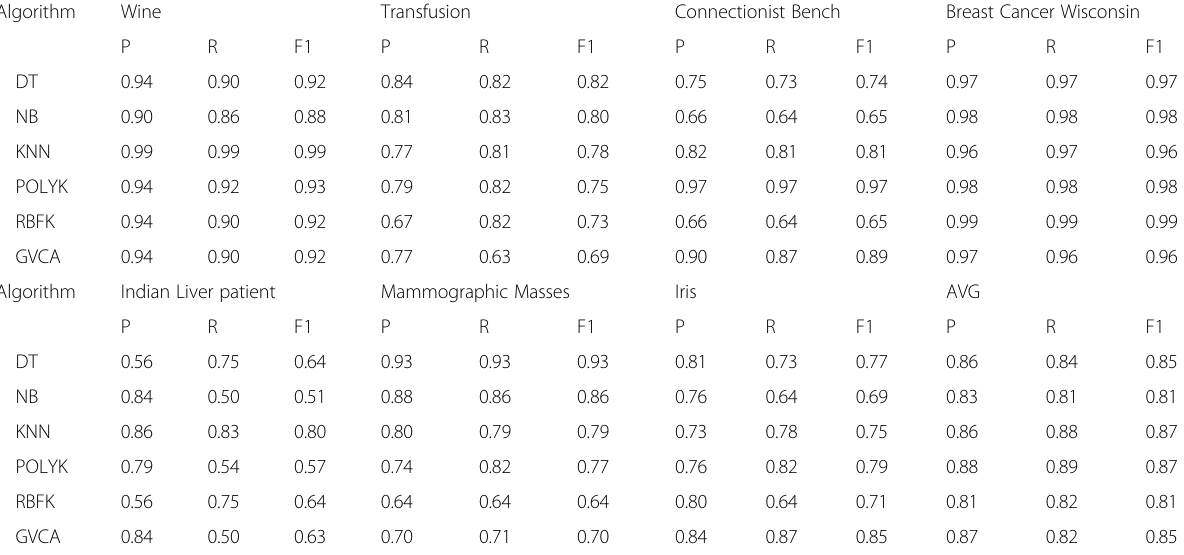
Table 11 Comparison of the classification performance on UCI dataset by the GVCA method and other classification methods Algorithm